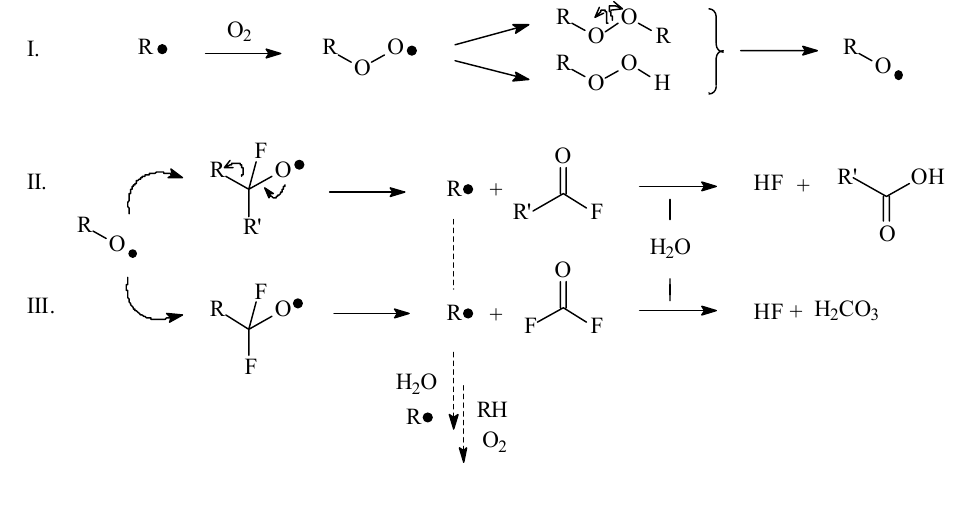
Figure 6. Schematic presentation of the defluorination